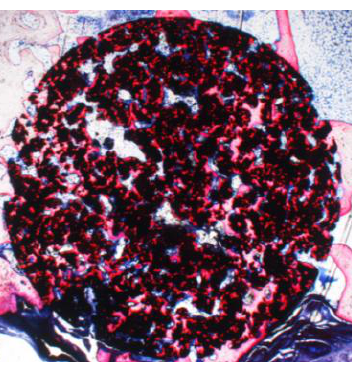
Figure 21. Bone formation in porous Ti metals subjected to no treatment and NaOH, HCl and heat treatments, 26 weeks after implantation into rabbit